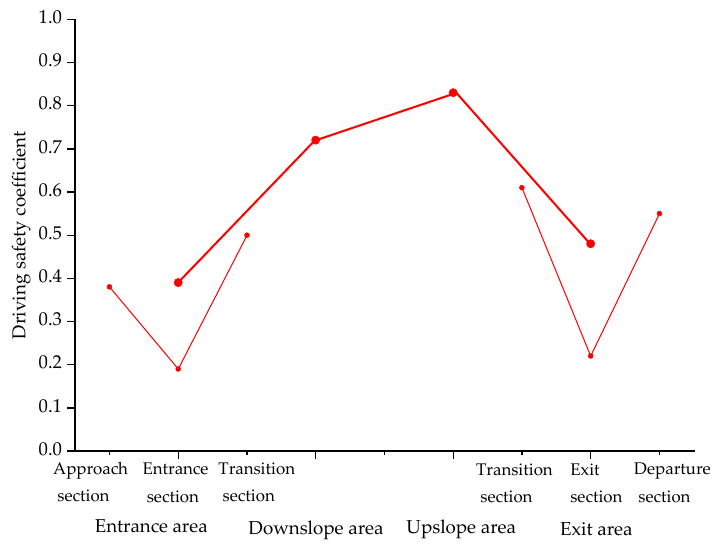
Figure 12. Variation of driving safety coefficient in different areas of the undersea tunnel.